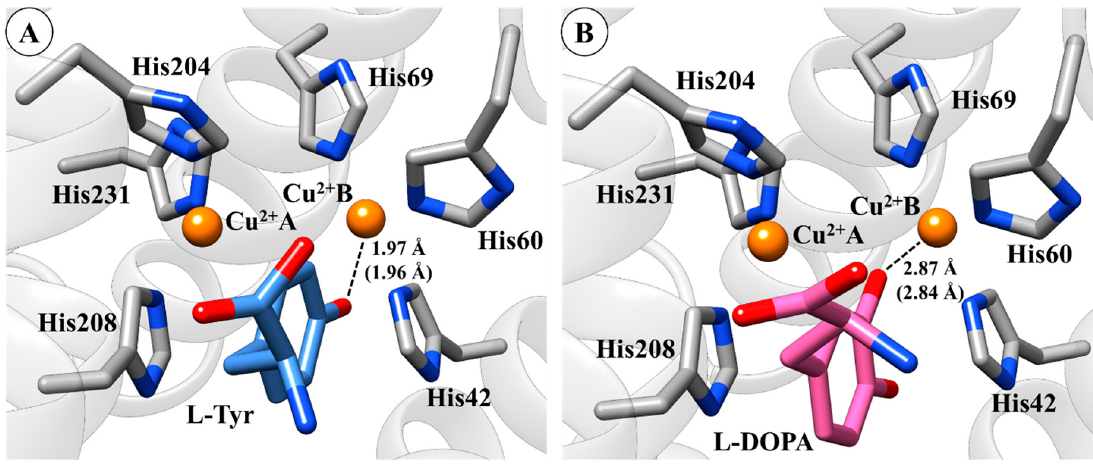
Figure 3. Binding mode of L -Tyrosine ( L -Tyr) ( A ) and L -3,4-dihydroxyphenylalanine ( L -DOPA) ( B ) in the active site of tyrosinase (TYR) obtained by re-docking. The 3D structures of the molecular docking results are available in Protein Data Bank (PDB) format in the Supplementary Materials (see Figure S1).